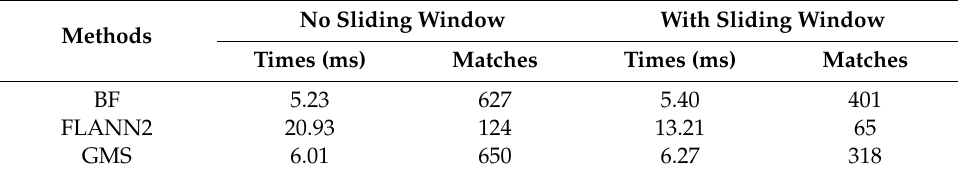
Table 1. Feature point matching time and quantity.